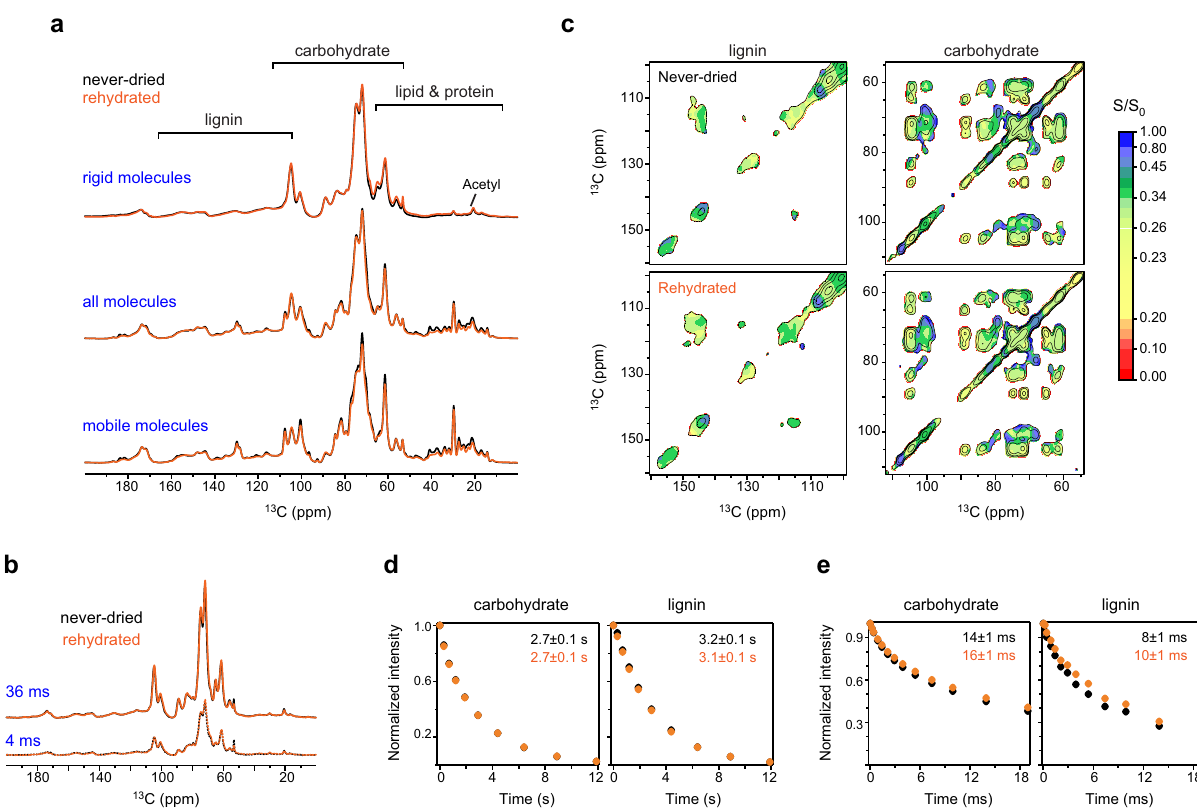
Fig. 5 Molecular-level dynamics and water association after dehydration and rehydration. A never-dried spruce sample was fi rst measured, and then freeze-dried and rehydrated for direct comparison. a Overlay of spectra collected using never-dried (black) and lyophilized and then rehydrated (orange) spruce stem samples showing high similarity for polysaccharides and lignin. From top to bottom are the CP, quantitative DP, and short recycle-delay DP spectra. The key regions of lignin, carbohydrate, and lipid are marked. b 1D water-to-carbohydrate polarization transfer spectra revealing similar water association for never-dried and rehydrated samples. The well-hydrated molecules are selected using a short 1 H mixing time of 4 ms while the equilibrated state is measured using 36 ms 1 H mixing. c Water-edited 2D hydration map showing comparable water-edited intensities (S/S 0 ) for both lignin and carbohydrate regions in the never-dried and the rehydrated samples. The ratio (S/S 0 ) is between the water-edited intensity (S) and the equilibrium intensity (S 0 ). d Average 13 C – T 1 relaxation plot, using the integrals of spectral regions for carbohydrates (left) and lignin (right). Source data are provided as a Source Data fi le. e Average T 1 ρ relaxation of carbohydrates and lignin in never-dried (black) and rehydrated (orange) samples. Error bars are standard deviations of the fi tting derived parameters. Source data are provided as a Source Data fi